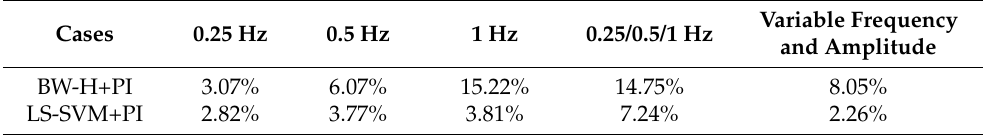
Figure 14. Tracking displacement results of various displacement signals: ( a ) 0.25Hz, ( b ) 0.5 Hz, ( c ) 1 Hz, ( d ) 0.25Hz/0.5Hz/1Hz, and ( e ) variable frequency and amplitude. Table 3. Tracking displacement REs of various signals.